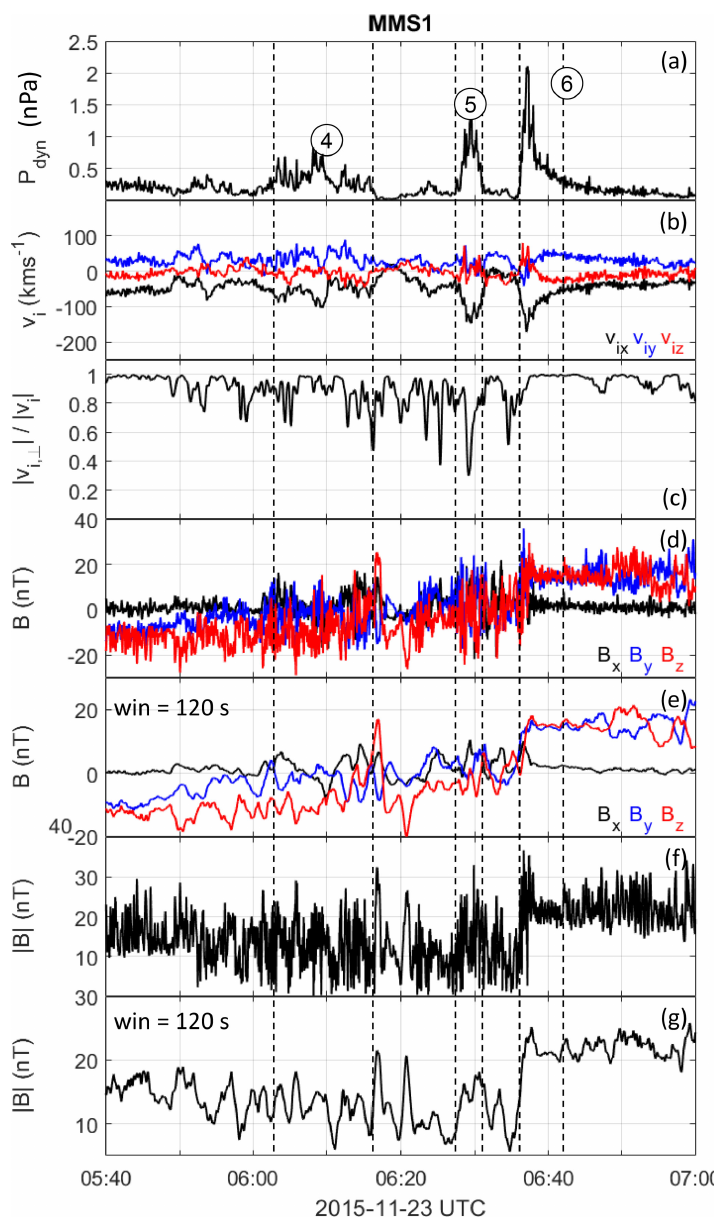
Figure 11. Magnetic configuration for jets on 23 November 2015, in the same format as Fig.